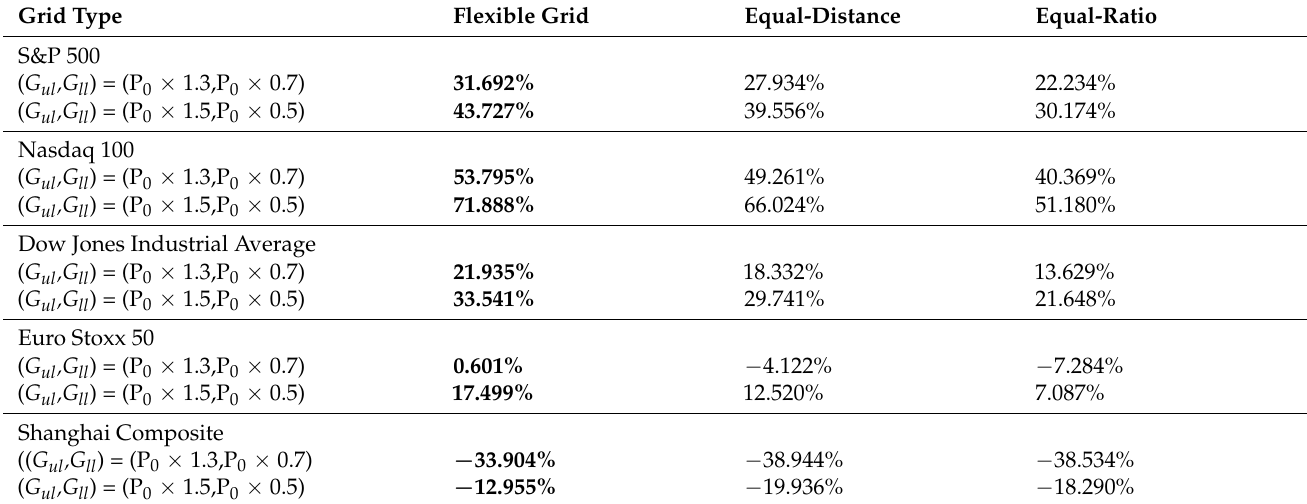
Table 3. ROI obtained by flexible grid, equal-distance grid, and equal-ratio